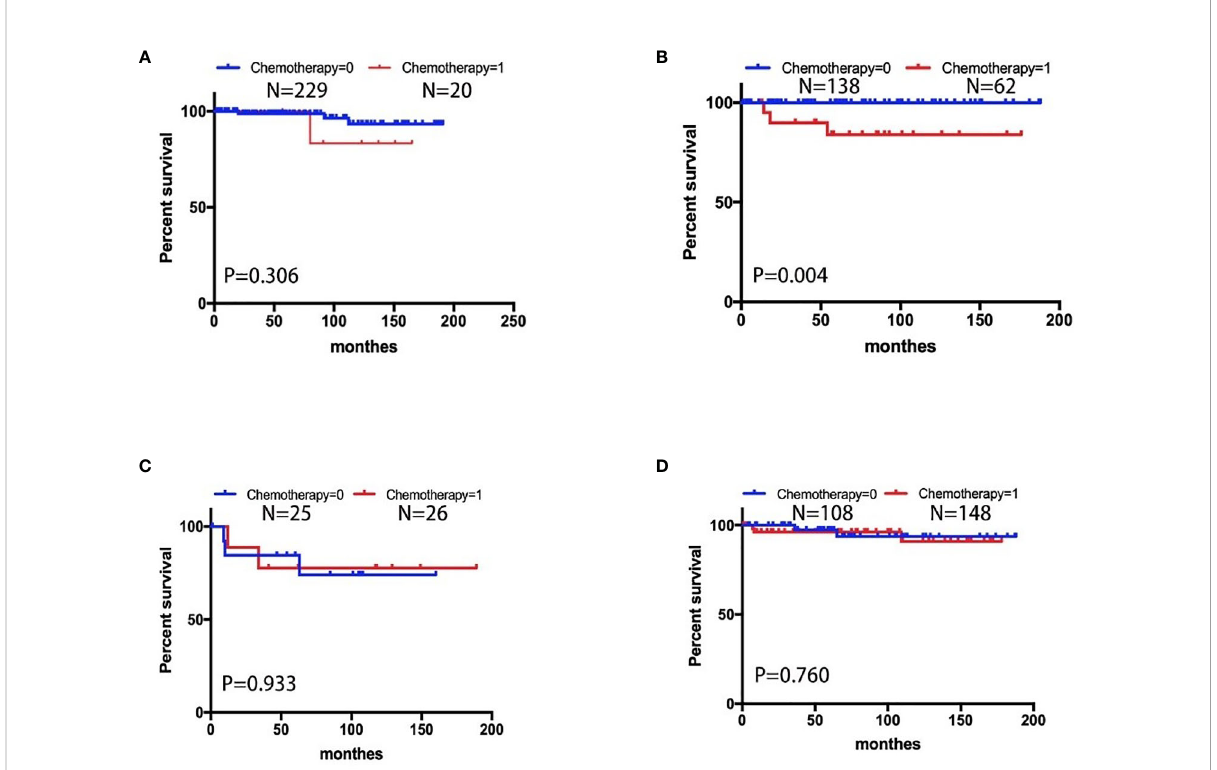
FIGURE 2 CSS curves strati fi ed in stage I MOC by chemotherapy. (A) Stage IA/IB-grade 1, 10-year CSS rates of chemotherapy = 83.33%, non- chemotherapy = 93.39%); (B) stage IA/IB-grade 2, 10-year CSS rates of chemotherapy = 84%, non-chemotherapy = 100%; (C) stage IA/IB-grade 3, 10-year CSS rates of chemotherapy=77.778%, non-chemotherapy = 74.038%; (D) stage IC, 10-year CSS rates of chemotherapy = 90.947%, non-chemotherapy = 93.688% [0 = non-chemotherapy; 1 = chemotherapy].